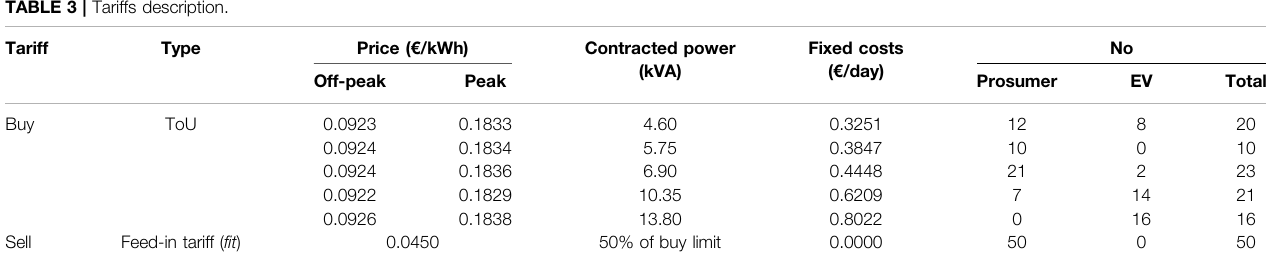
TABLE 3 | Tariffs description.